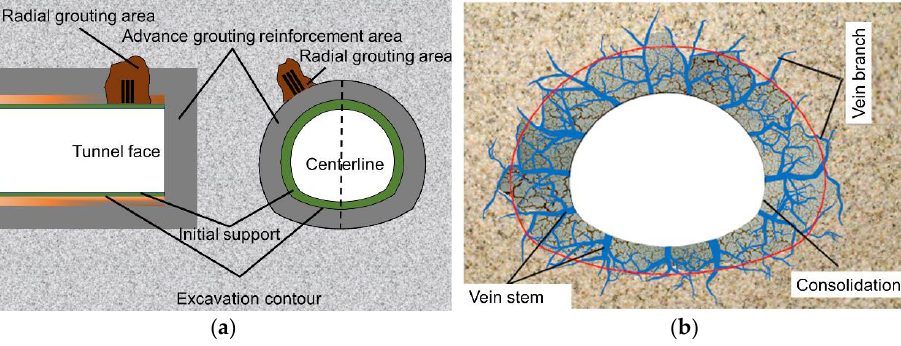
Figure 18. Comparison of grouting methods [103,108]. ( a ) Single full section crack grouting; ( b ) new concept of compound grouting.